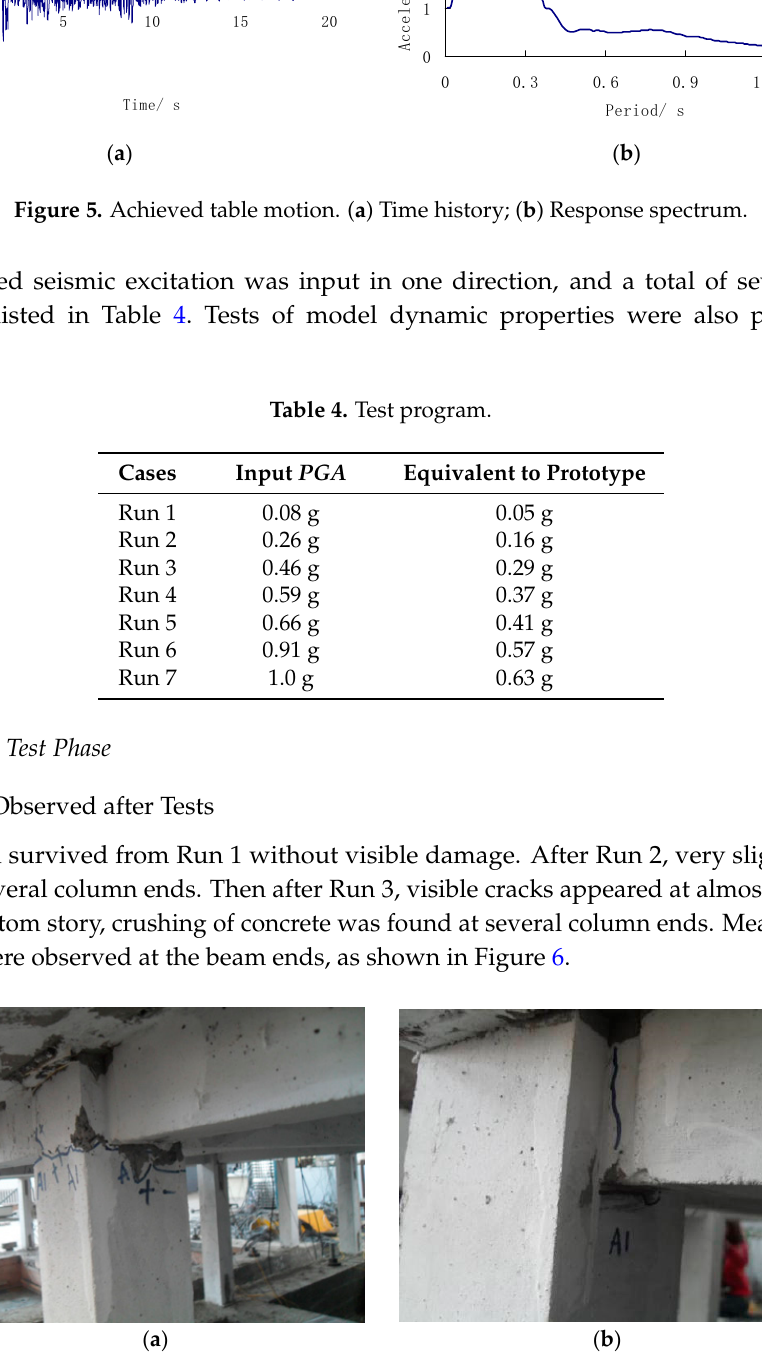
Figure 6. Model damage after Run 3. ( a ) Concrete crushing at the column end; ( b ) Slight crack at the beam end.